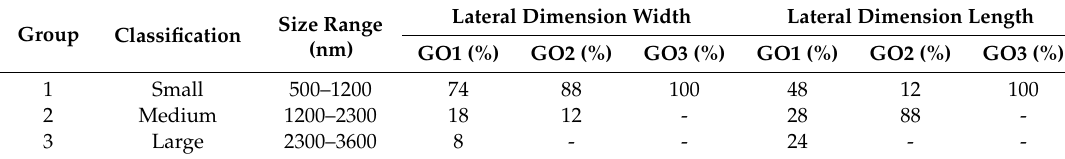
Table 1. Percentages of population size distribution for used